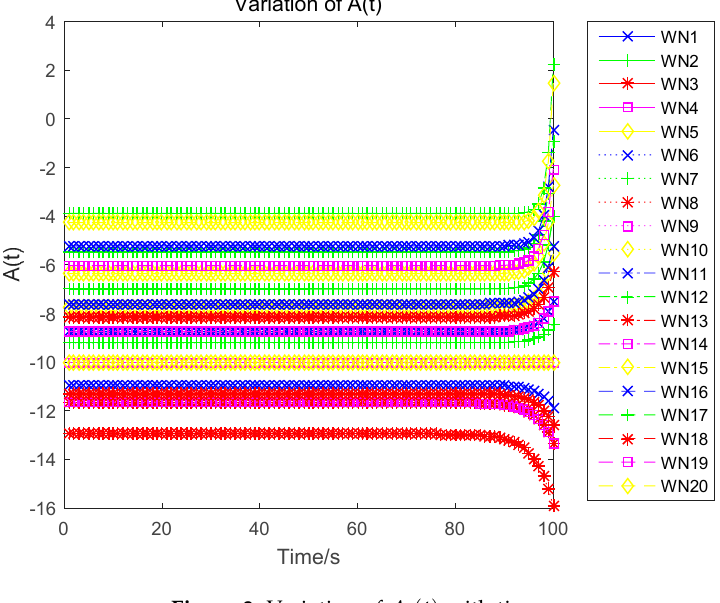
Figure 3. Variation of A i ( t ) with time.